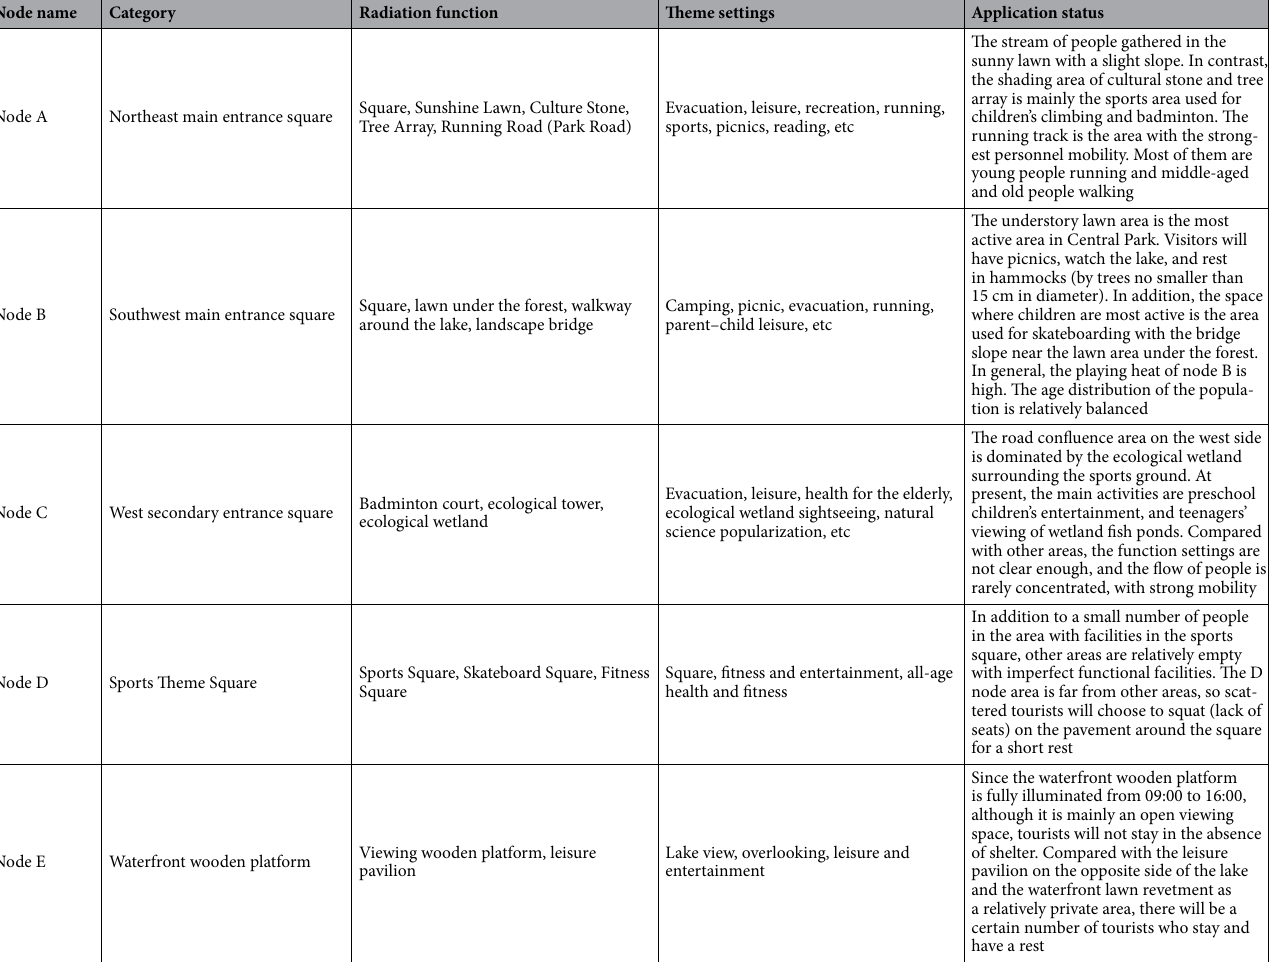
Table 1. Landscape node and application of the Central